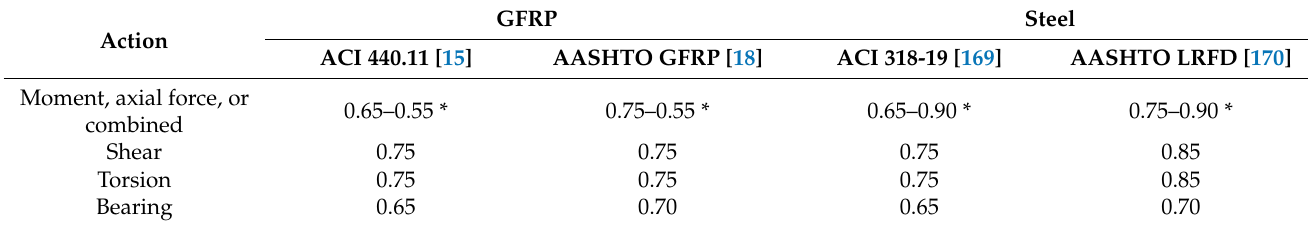
Table 5. Strength reduction factors for different design guides and codes.